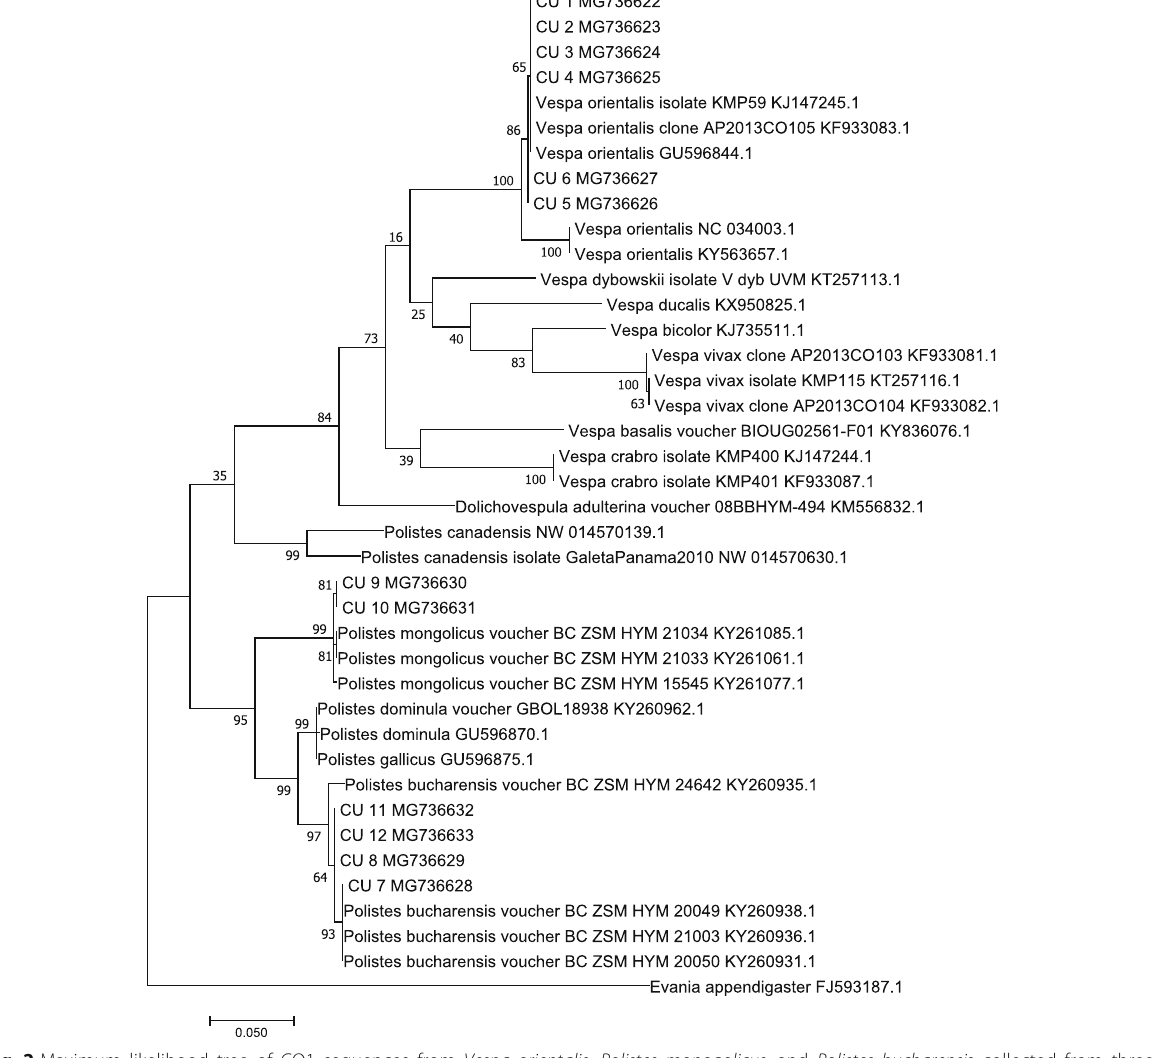
Fig. 2 Maximum likelihood tree of CO1 sequences from Vespa orientalis , Polistes monogolicus , and Polistes bucharensi s collected from three different governorates in Egypt (accession no. CU_1 MG736622 – CU_12MG736633). The nodes are shown with their bootstrap values; Evania appendigaster was used as the